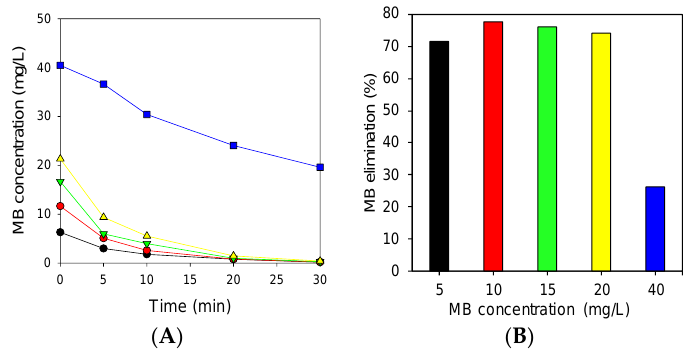
Figure 5. MB degradation under UV radiation depending on the initial MB concentration ( A ). MB degradation after 10 min treatment ( B ).